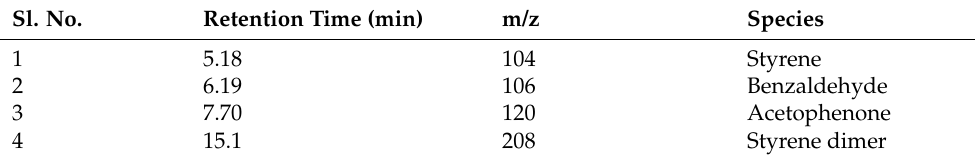
Table 6. The retention times and corresponding masses of the major fragments for PSt. Sl.